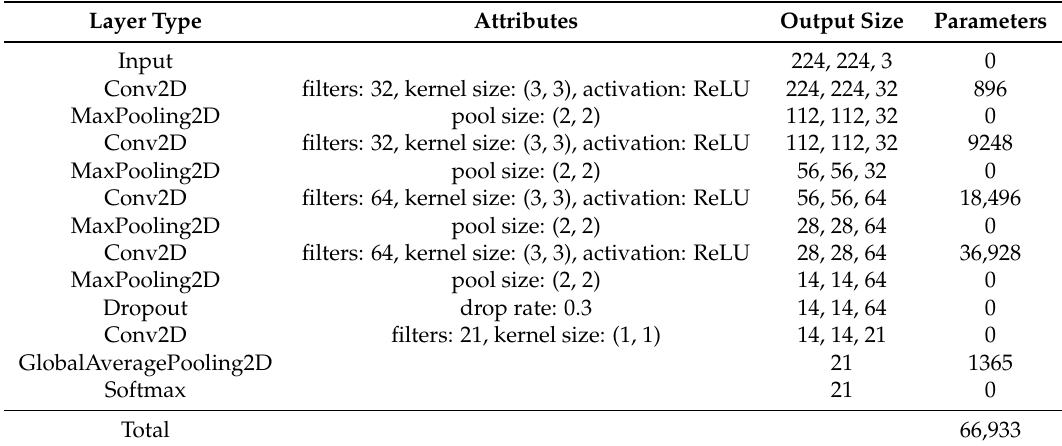
Table A3. The structure of the student CNN model in experiments on UCMerced